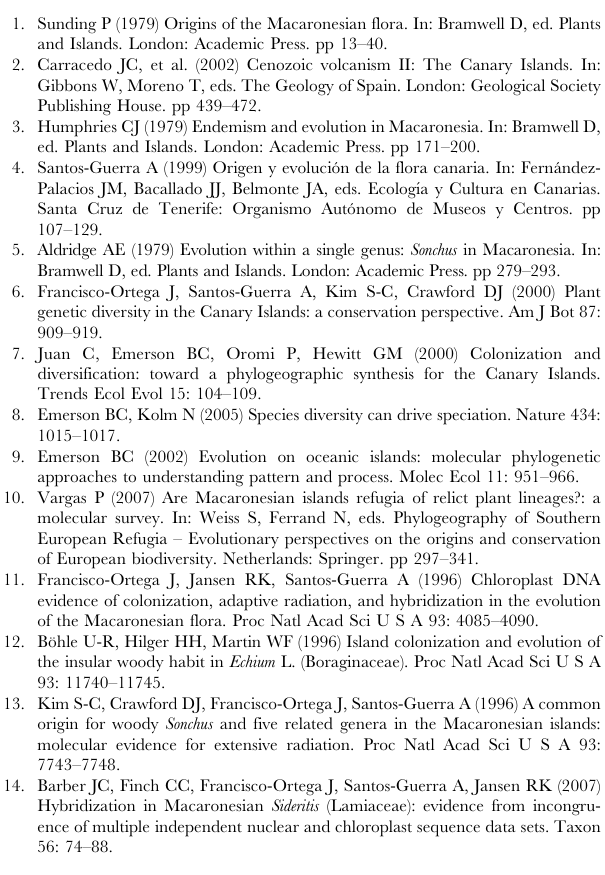
Figure S1 Phylogenetic classification of the flowering plants and the position of five plant groups studied. The tree is from the Angiosperm Phylogeny Group (version 7, June 2007) (http:// Found at: doi:10.1371/journal.pone.0002139.s001 (3.06 MB TIF) Figure S2 Maximum likelihood phylogram (model: SYM + G, -ln = 1579.7311) of the woody Sonchus alliance (Asteraceae) based on ITS sequence of nrDNA. Gray circle represents calibration point. (S.= Sonchus ) (1 =dispersal to the Canary Islands, 2= dis- persal to Madeira, 3= dispersal to Cape Verde). Found at: doi:10.1371/journal.pone.0002139.s002 (0.96 MB TIF) Figure S3 Maximum likelihood phylogram (model: GTR + I + G, -ln = 3228.8472) of Echium (Boraginaceae) based on ITS and cpDNA sequences. Gray circle represents calibration point. (1 =dispersal to the Canary Islands, 2= dispersal to Cape Verde, 3 = dispersal to Madeira). Found at: doi:10.1371/journal.pone.0002139.s003 (0.79 MB TIF) Figure S4 Maximum likelihood phylogram (model: TIM + G, -ln = 2110.9453) of Sideritis (Lamiaceae) based on ITS sequence.